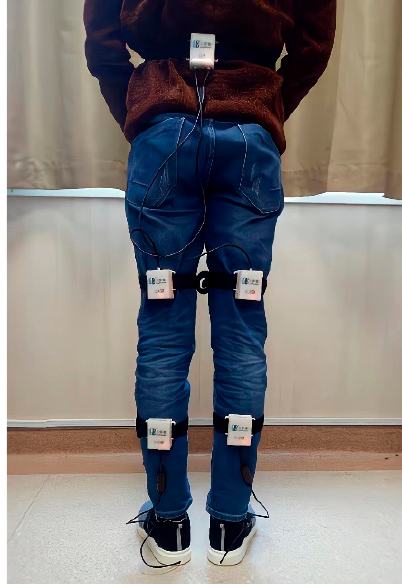
Figure 1. Photograph of JiBuEn gait-analysis system.